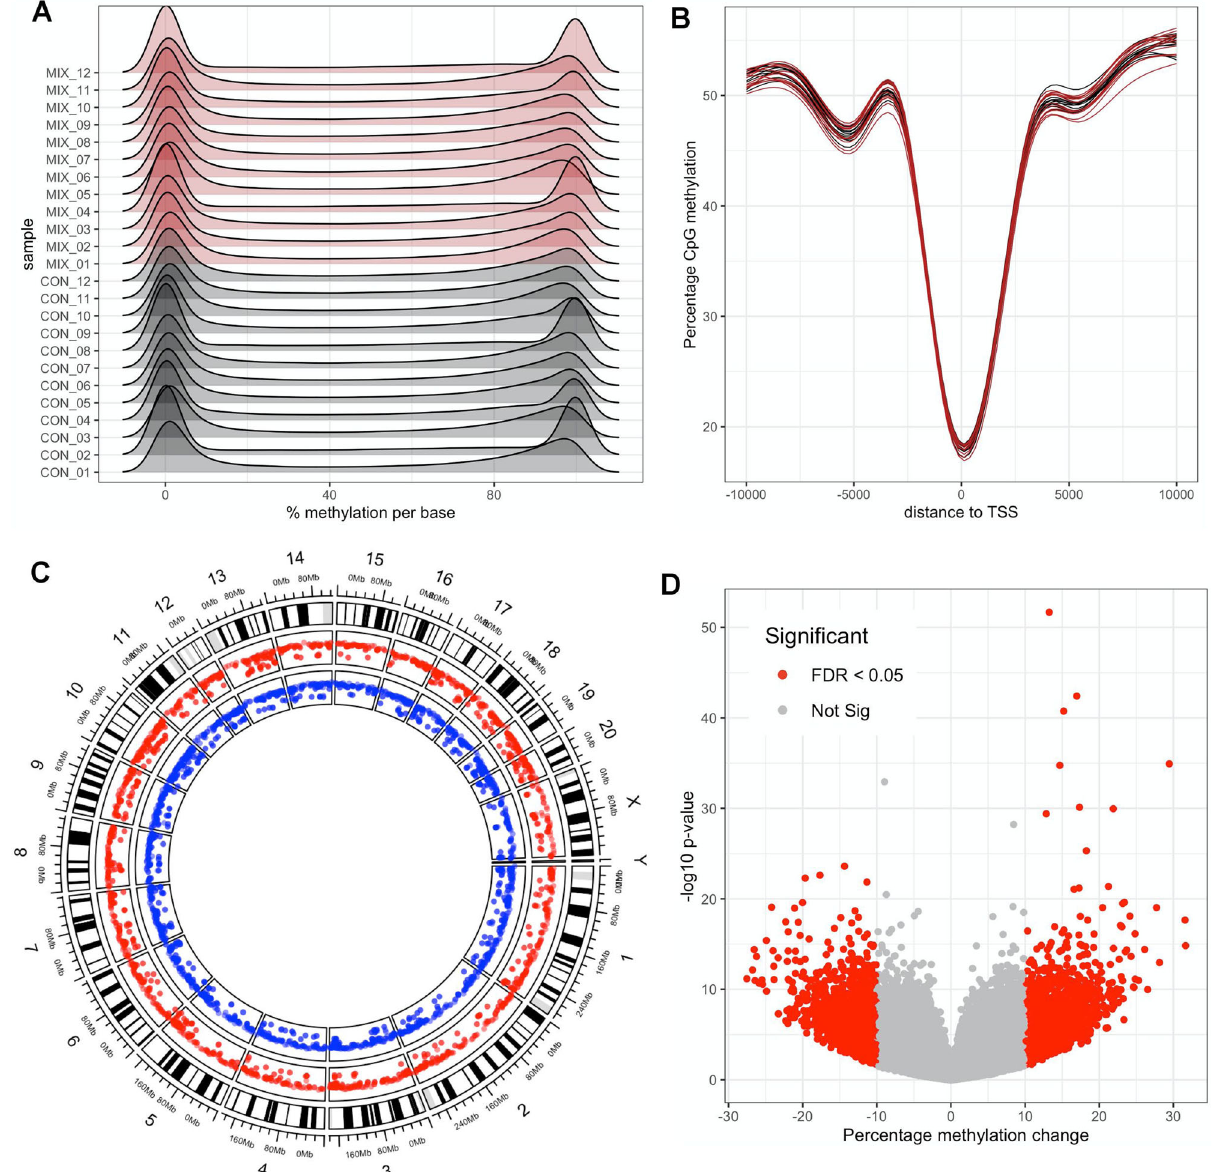
Fig. 6 Reduced representation bisul fi te sequencing of liver samples from Sprague – Dawley rats exposed for 90 days to the mixture of six pesticides. A Percentage DNA methylation pro fi le shows a bimodal distribution of methylation calls for each sample. B CpG methylation decreases around transcription start sites. C Circos plot shows that differentially methylated CpG sites (blue track, hypomethylated; red track, hypermethylated) are scattered around the genome. D Volcano plots of differentially methylated CpG sites shows that a large number of CpG loci are differentially methylated across the rat liver genome with moderate methylation